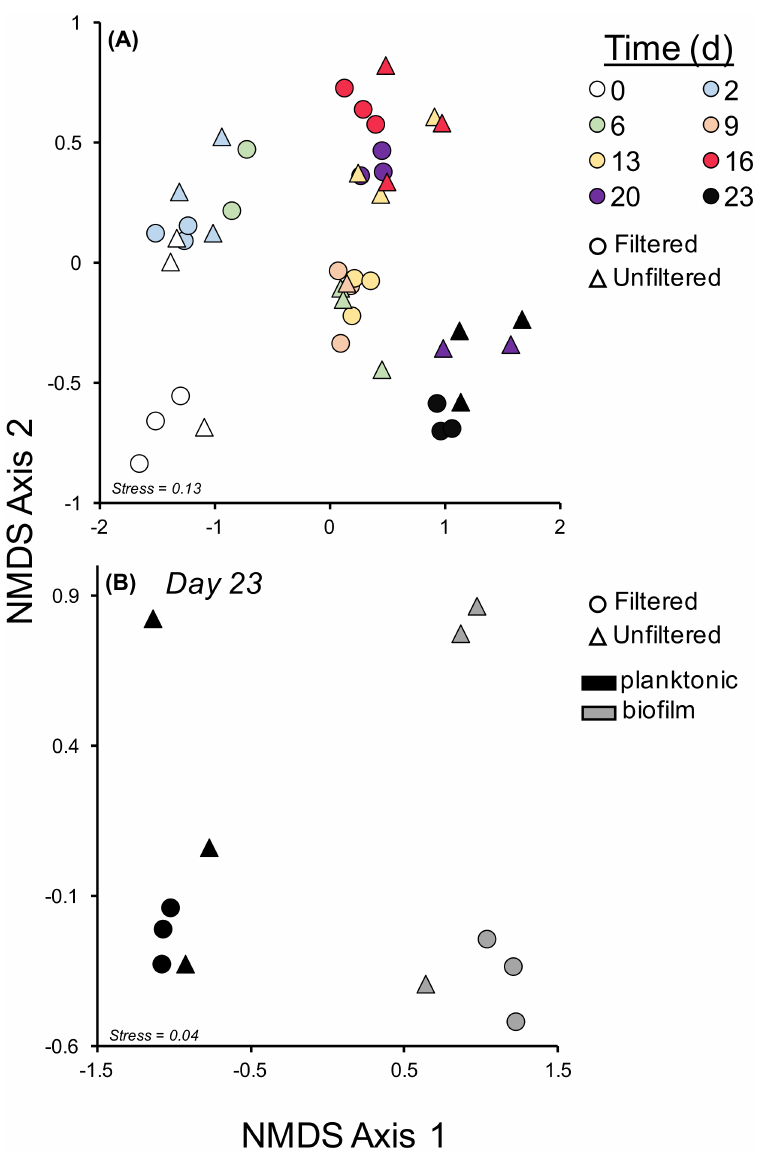
Fig 5. Bacterial community dynamics over time. Non-metric Multidimensional scaling (NMDS) ordinations for bacterial planktonic communities over time for filtered (circles) and unfiltered (triangles) samples (Panel A) and for biofilm (gray symbols) and planktonic communities (black symbols) at the end of the experiment (day 23; Panel B).